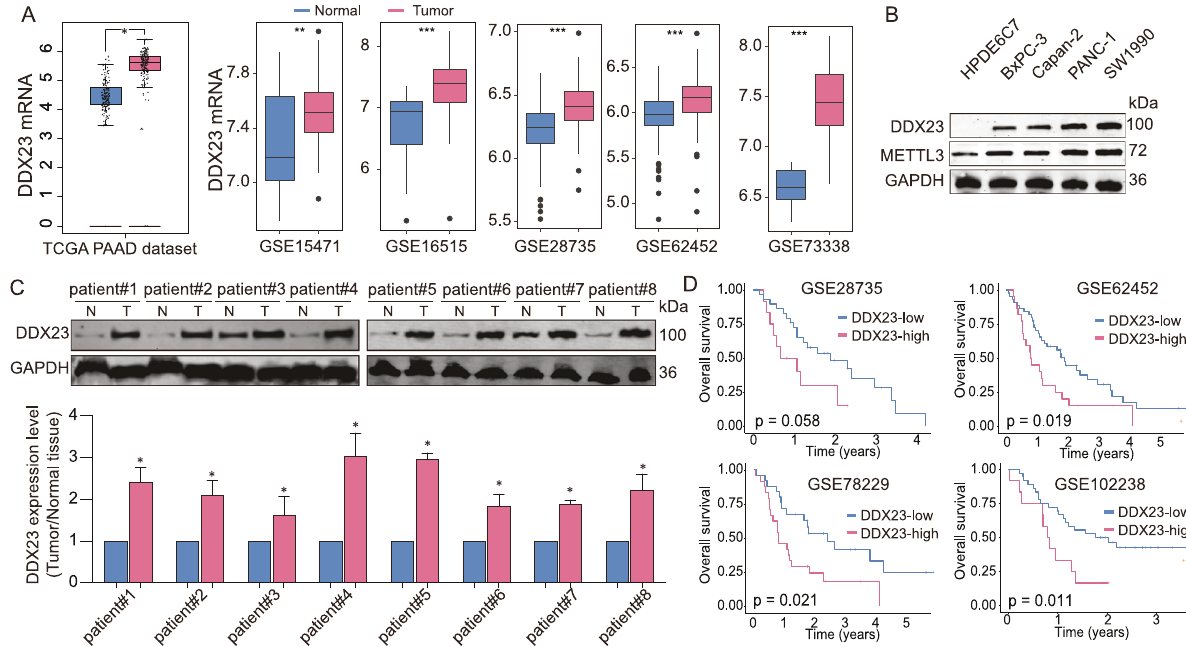
Fig. 4 DDX23 was signi fi cantly upregulated in pancreatic cancer and predicted poor survival outcomes. A The differential gene expression analyses of TCGA and GEO pancreatic cancer data showed the signi fi cant upregulation of DDX23 in tumor tissues. B DDX23 protein expression in pancreatic cell lines was analyzed using western blotting assay. C DDX23 protein level in tumor and adjacent tissues of eight patients. D The survival analysis results of pancreatic cancer patients distinguished by DDX23 level. Datasets were obtained from the